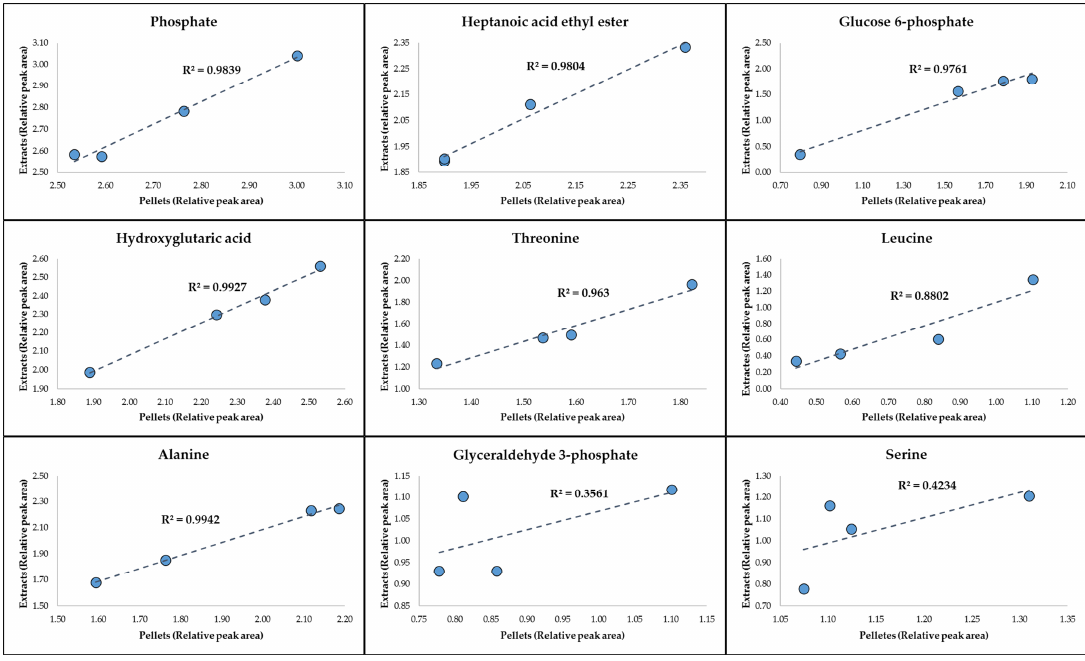
Figure 5. Plots of GC-MS relative peak areas of the significant metabolites detected in the cell pellets vs. those detected in cell extracts.